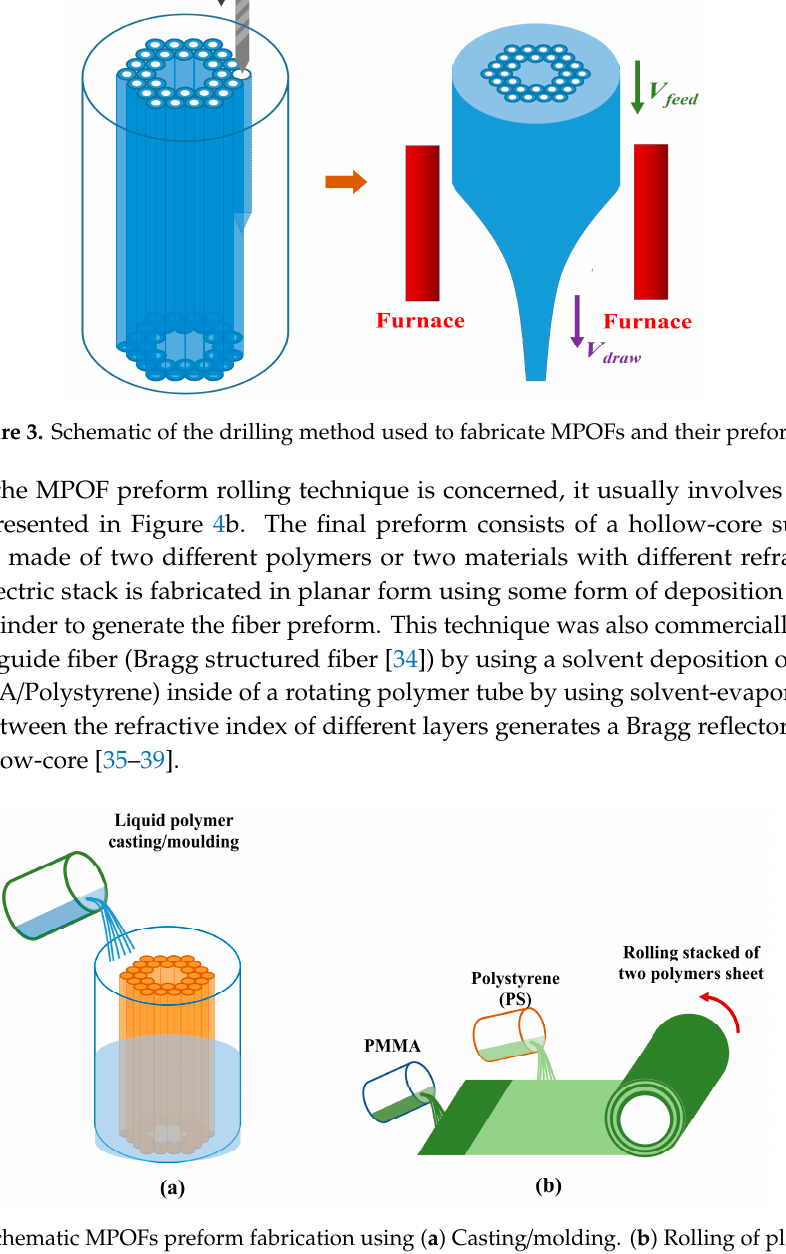
Figure 5. Schematic MPOFs preform fabrication using a liquid polymer extrusion and billet extrusion technique. Rapid development of additive manufacturing technologies and the related reduction in cost, moved the fabrication of 3D models into the next generation of high precision manufacturing. 3D printing has drawn a great interest in many fields, such as medicine, art, engineering, and science. Many manufacturing techniques allow to print 3D models, including photo-polymerization, selective laser sintering (SLS), continuous liquid-interface production (CLIP), and fused-deposition modelling (FDM). In photo-polymerization, a laser or light-emitting diode (LED) is used to scan across a plane and the material polymerization occurs when light interacts with the monomer. To achieve the 3D profile, the laser or LED is controlled by using a three-axial stage and the process is repeated layer by layer. SLS is one of the most popular 3D printing techniques because it can be used to print not only polymer